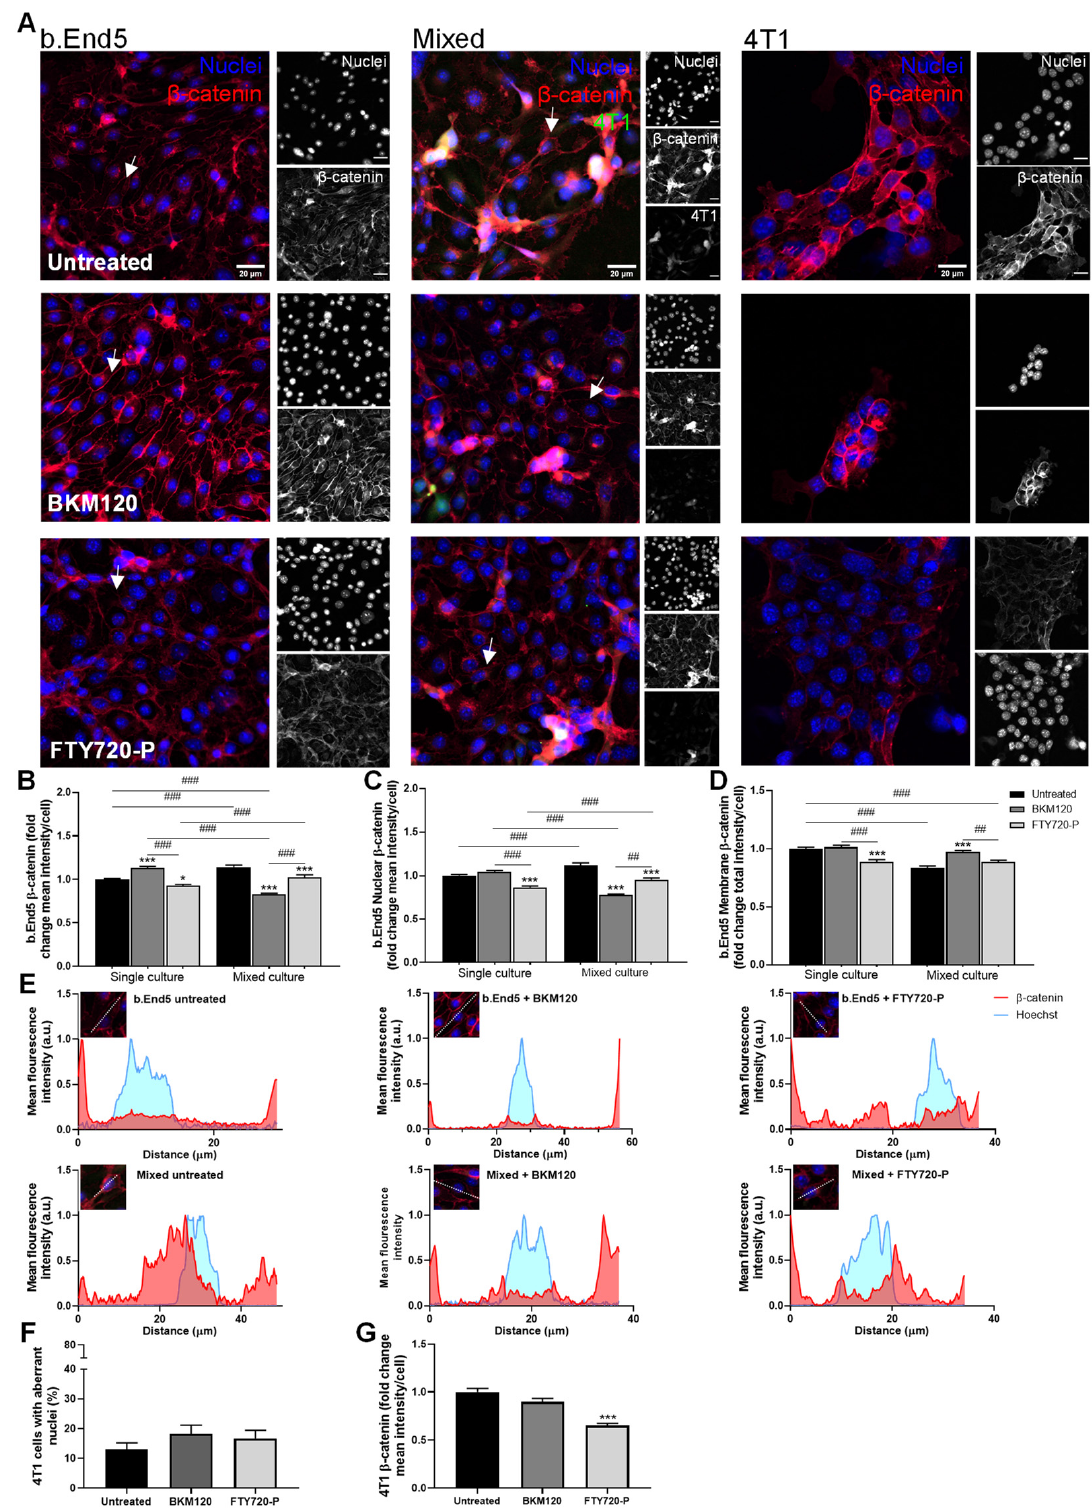
Figure 4. BKM120 induces endothelial barrier properties through the increase in membrane β -catenin expression. Confluent monolayers of b.End5 cells under physiological laminar non-pulsatile shear stress were exposed to 4T1 cells (previously labelled with CellTracker™ CMFDA Green Dye) and treated with BKM120 or FTY720-P (0.1 µM), or DMEM (untreated), for 24 h and the expression of the AJs protein, β -catenin (red), in single and mixed cultures was evaluated by immunofluores- cence analysis. Hoechst 33342 was used as counterstaining for nuclei (blue). Scale bar: 20 µm. ( A ) Treatment with BKM120 or FTY720-P induced an increase in β -catenin expression in endothelial cells exposed to 4T1 cells, particularly at cell membrane (white arrows). Semi-quantitative analysis of endothelial β -catenin ( B ) mean intensity per cell, ( C ) nuclear intensity, and especially ( D ) mem- brane intensity validated these observations. ( E ) The localisation of β -catenin was studied through plot profiles of pixel intensity throughout an endothelial cell (edge to edge). Semi-quantitative